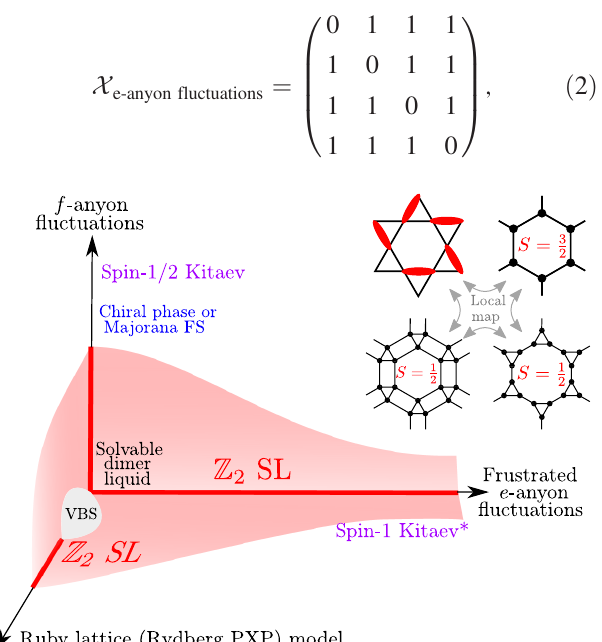
FIG. 1. Schematic phase diagram. We consider an emergent dimer model on the kagom´e lattice, which can locally be written as a four-state model on the honeycomb lattice (Sec. II) or two- body spin- 1 = 2 models on the ruby or star lattices (Sec. VI). Weak e - or f -anyonic fluctuations generate a solvable dimer liquid similar to the toric code [50]. Strong fluctuations give effective Kitaev-type Hamiltonians: In the case of f fluctuations, this is the paradigmatic spin- 1 = 2 Kitaev honeycomb model, whereas for (frustrated) e fluctuations, we discover a new spin-1 quadrupolar Kitaev liquid. The f -fluctuating model is free-fermion solvable and contains a non-Abelian phase or Majorana Fermi surface (depending on the choice of sign); the e -fluctuating model is dual to the frustrated Ising model on the kagom´e lattice, showing that the Z 2 SL persists to the spin-1 Kitaev limit. Finally, our parent model also contains the ruby lattice Ising model with Rydberg blockade [34], and we numerically confirm that its SL is adiabatically connected to the aforementioned solvable dimer